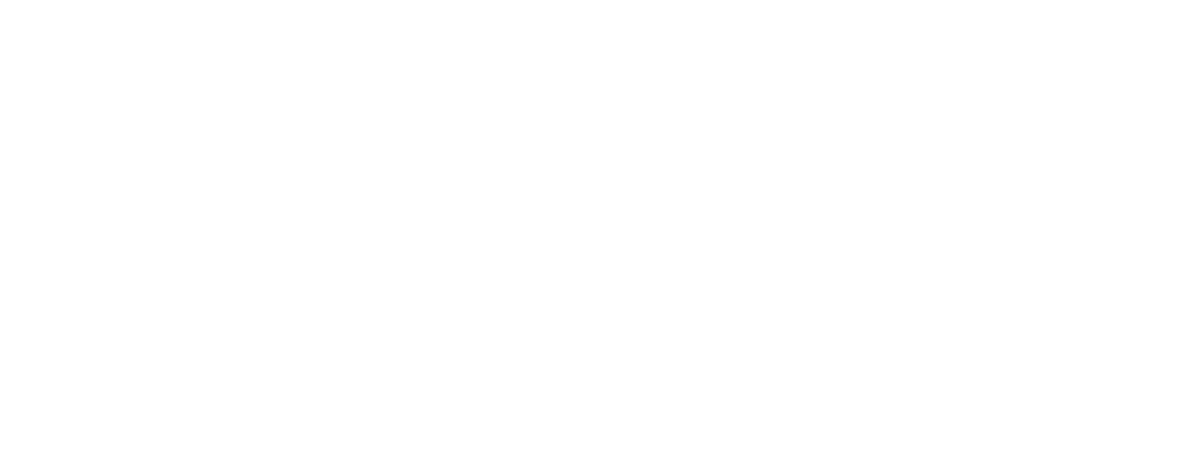
FIGUREA1 |The effect of hAAT onTLR2 andTLR4 during cecal puncture (CP) model . CP was performed with the following groups: untreated sham-operated mice (Sham, n = 2), untreated CP-operated mice ( n = 4), mice pretreated with hAAT (60mg/kg), and then CP-operated ( n = 5). Also, CP-treated mice were introduced recombinant gp96 (i.p., 80 µ g/kg, once, 24h